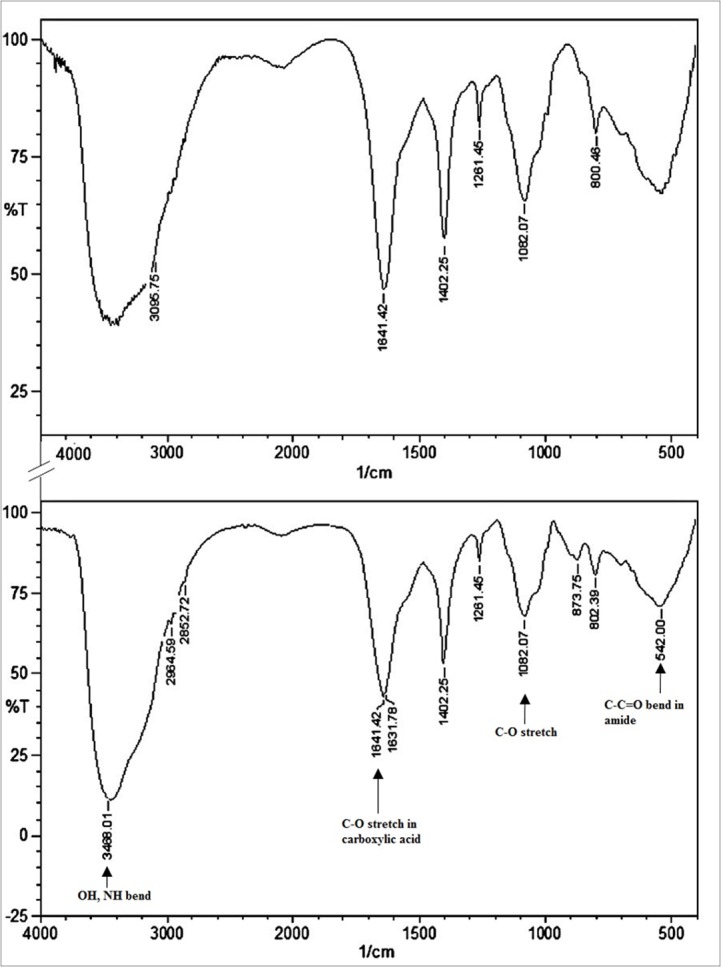
FTIR spectrum of MSR2 before (a) and (b) after Cr(VI) biosorption.